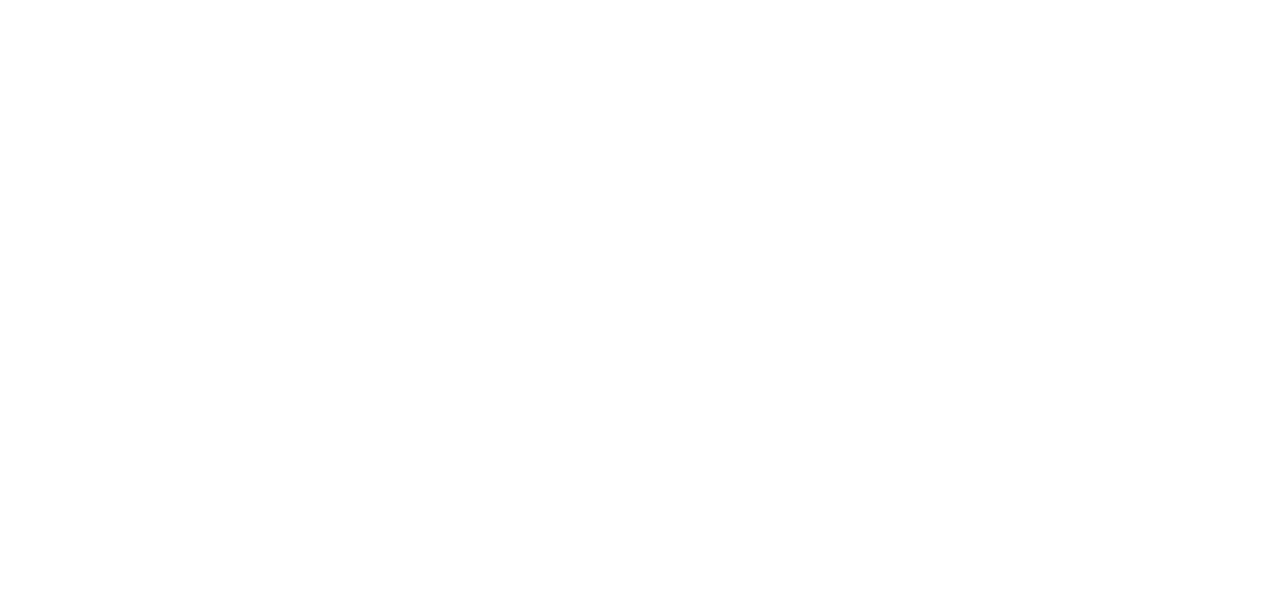
Frontiers in Nutrition | www.frontiersin.org